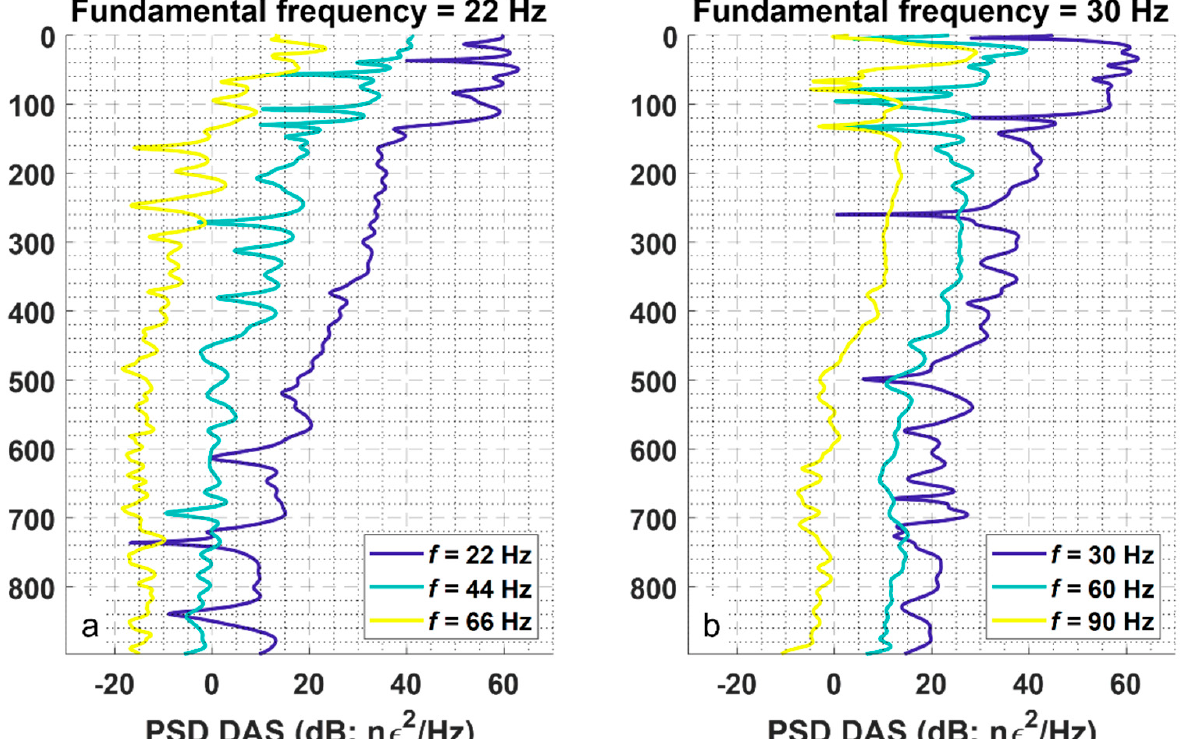
Figure 5. ( a ) Power spectral densities of the signals carried as the fundamental frequency of 22 Hz and its higher harmonics 44 and 66 Hz along the well. The data recorded when the first vibrator was working solo at SP1. ( b ) Power spectral densities of the signals carried as the fundamental frequency of 30 Hz and its higher harmonics 60 and 90 Hz along the well. The data was recorded when the first vibrator was working solo at SP2.